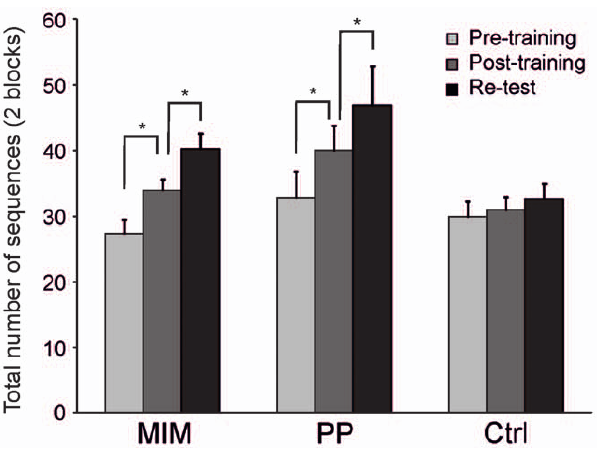
Figure 3. Effect of training on the total number of correct sequences. The total number of correct sequences performed during the two-block practice of the pre-training, the post-training and the re- test sessions, have been computed for the three different groups of subjects participating in Experiment # 1. Both MIM and PP groups increased their performance significantly in the post-training session, while no significant difference was found in the Ctrl group. Similarly, during re-test, only in the MIM and PP groups, we found an increase in the total number of sequences, demonstrating the occurrence of an early boost effect. Error bars indicate one SD.